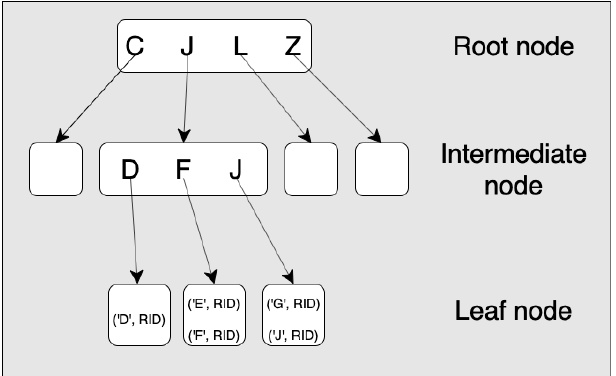
Figure 3. A diagram showing the standard three-tier structure of a B-tree index. The root node is the top level and lists the end of a range of key values represented on each of the intermediate nodes in the middle level. There can be more than one level of intermediate nodes, with higher levels of intermediate nodes pointing to other intermediate nodes instead of leaf nodes. The intermediate nodes point to the leaf nodes. The leaf pages hold the key values along with Record IDs (RIDs) that tell Database Management System (DBMS) where to find the data on the data pages of the